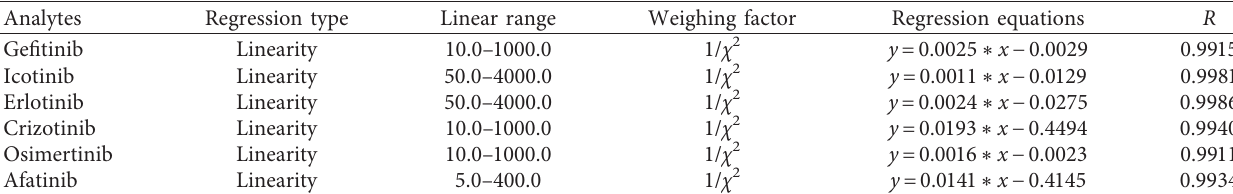
Figure 2: Representative MRM chromatograms of six TKIs: (a) blank sample; (b) blank sample spiked with the LLOQ concentration of six TKIs and IS; (c) real sample concentration (icotinib: 504ng/mL, erlotinib: ND, gefitinib: 623ng/mL, crizotinib: 327ng/mL, afatinib: ND, osimertinib: 250ng/mL, and IS: 100ng/mL). ND � not detected. Table 2: Linearity regression parameters of six